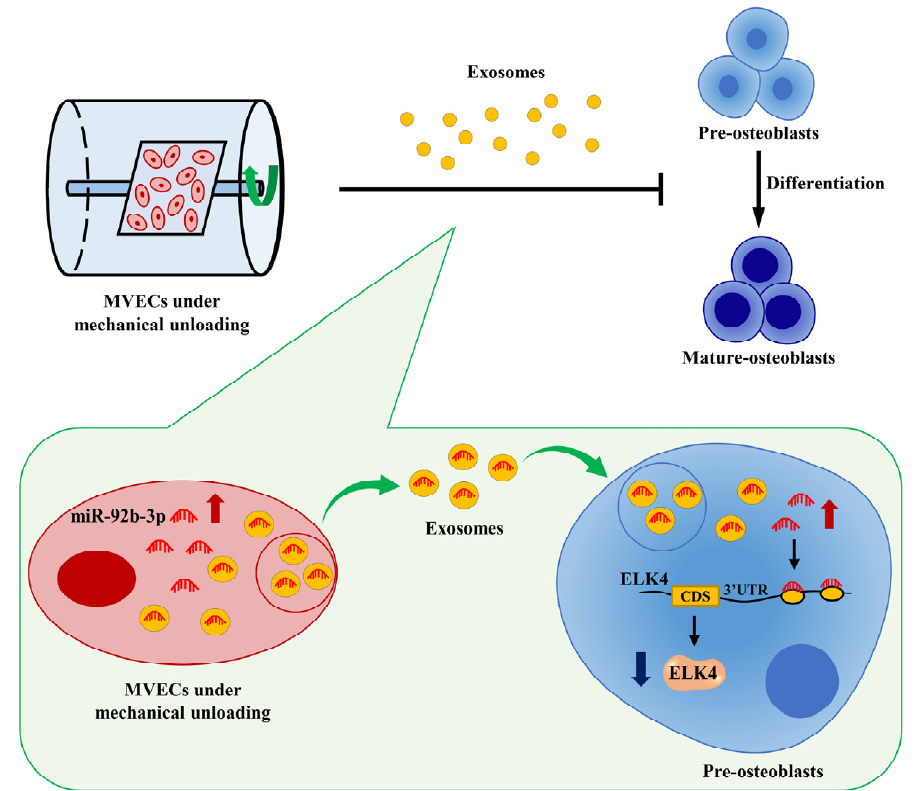
Figure 7. A schematic diagram illustrating the molecular mechanisms of which exosomes derived from MVECs cultured under mechanical unloading regulate osteogenic differentiation. miR-92b-3p expression was increased in MVEC-secreted exosomes after mechanical unloading, resulting in the upregulation of miR-92b-3p expression in MC3T3-E1 cells cocultured with Clino Exos. ELK4, the direct target of miR-92b-3p, is decreased in MC3T3-E1 cells treated with Clino Exos, thus inhibiting osteogenic differentiation. The blue arrow represents inhibition, and the red arrow represents promotion.